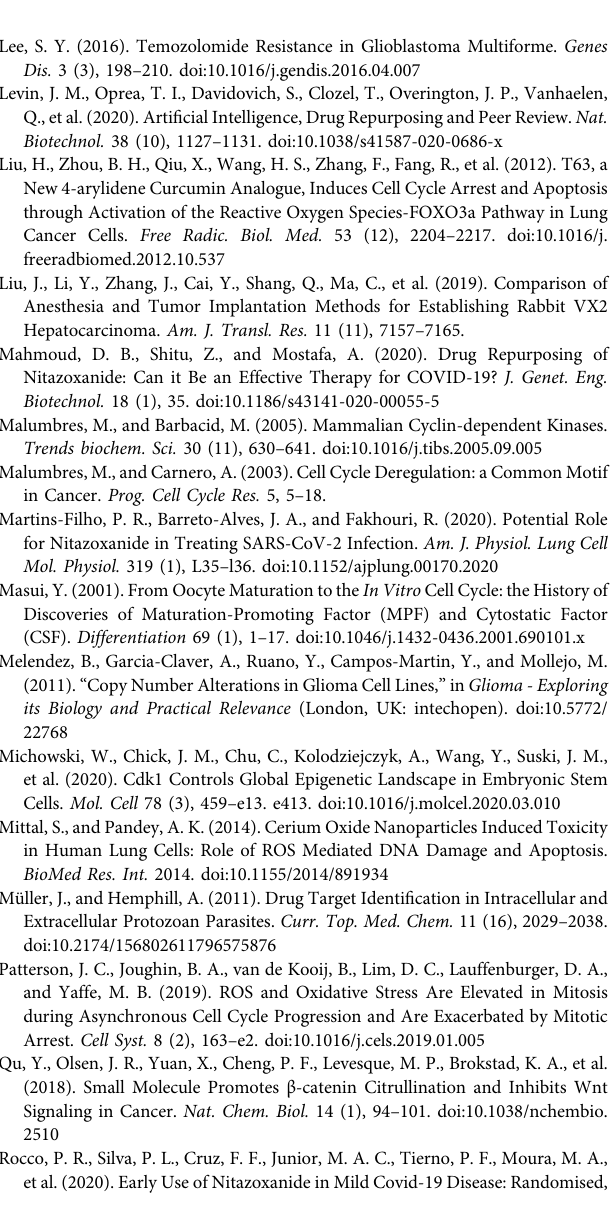
Supplementary Figure S1 | Bioinformatic analysis of the potential targets of TIZ and target-TIZ docking results. (A) Gene ontology (GO) biological process